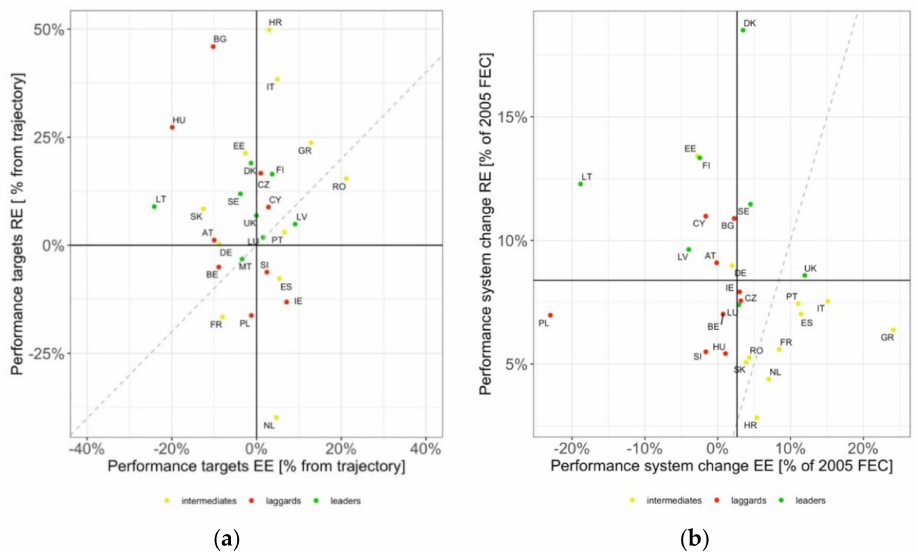
Figure 3. Performance towards 2020 targets as expressed in the 2017 NREAPs and 2017 NEEAPs, measured as the mean distance between 2016–2018 to a linear trajectory between 2005 and 2020 ( a ). Positive numbers indicate that countries are on or above track to meet the 2020 target. Performance as total deployed renewables (% of 2005 FEC) and total energy saved (% of FEC 2005) 2005–2020 (system change). The solid lines indicate average system change performance. Due to missing data we excluded Malta ( b ). In both panels, the dotted line indicates equal performance for energy e ffi ciency and renewable